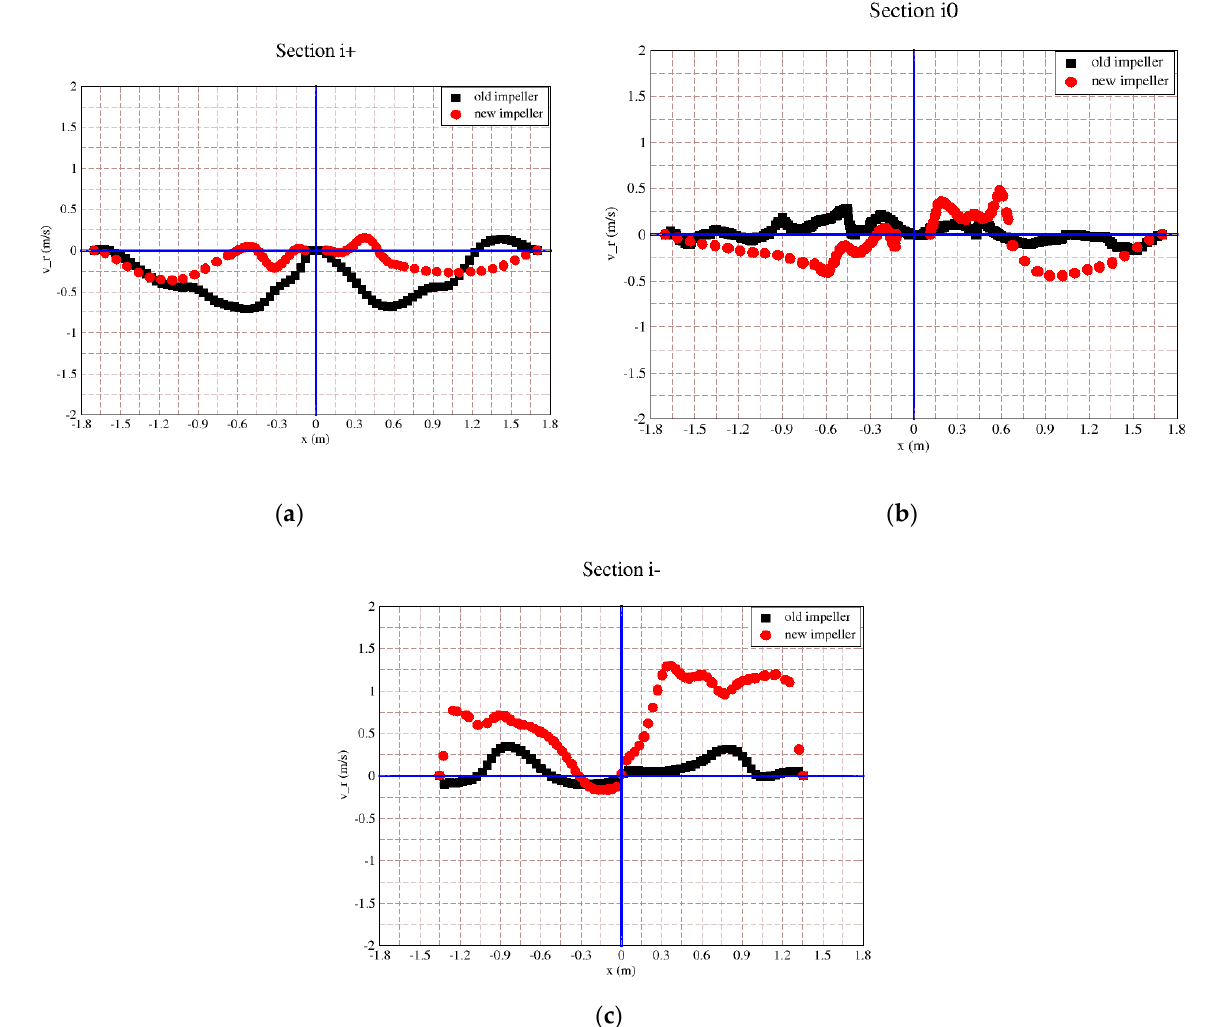
Figure 8. Radial velocity distribution of liquid phase at various axial levels, old impeller vs. new impeller: ( a ) above impeller; ( b ) impeller level; ( c ) under impeller.